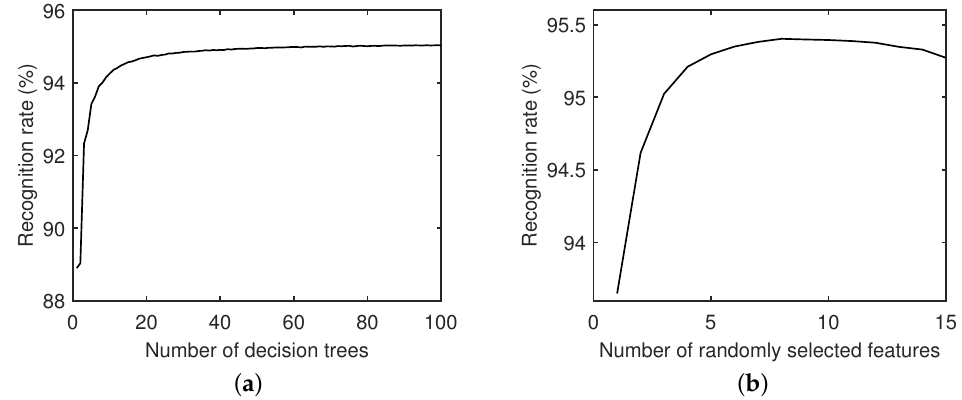
Figure 12. Parameter determination of the classifier. ( a ) Number of decision trees and ( b ) number of randomly selected